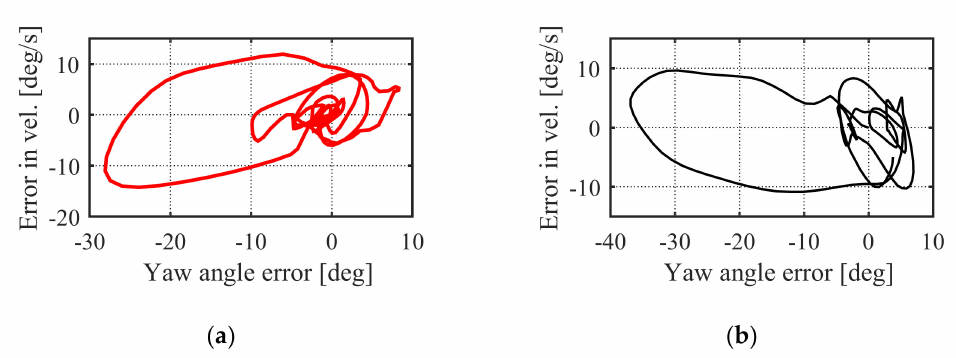
Figure 24. The experimental phase-portrait: ( a ) Proposed controller; ( b )